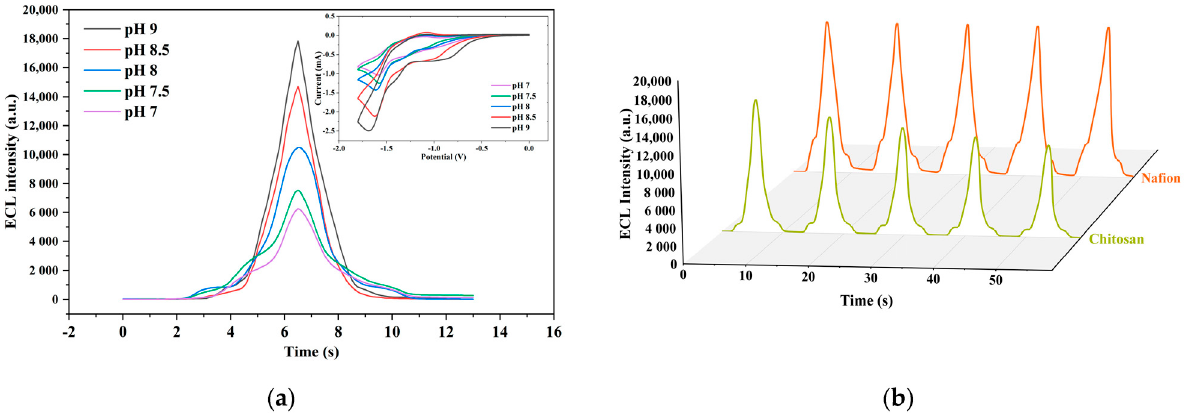
Figure 2. ( a ) Optimization of pH value of working solution, insert was CV curves at different pH values; ( b ) ECL curves of electrodes modified with Nafion and chitosan,